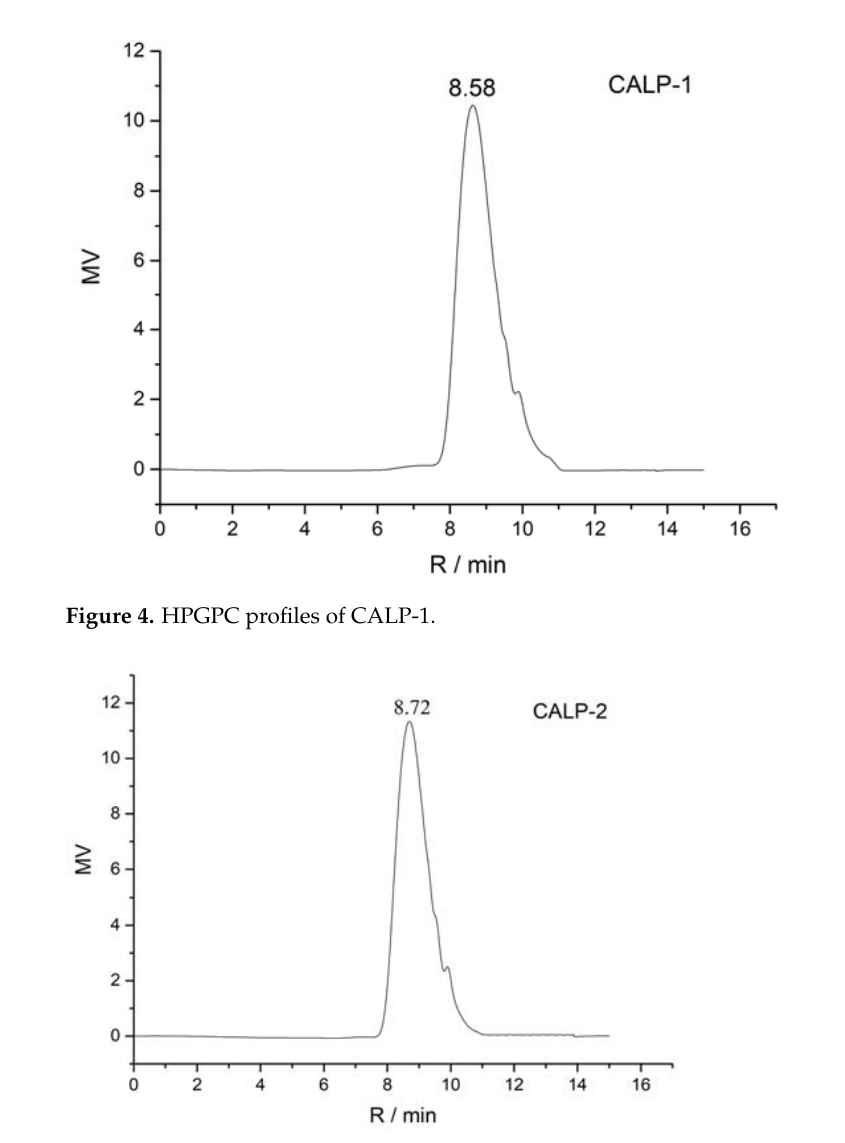
Figure 5. HPGPC profiles of CALP ‐ 2.